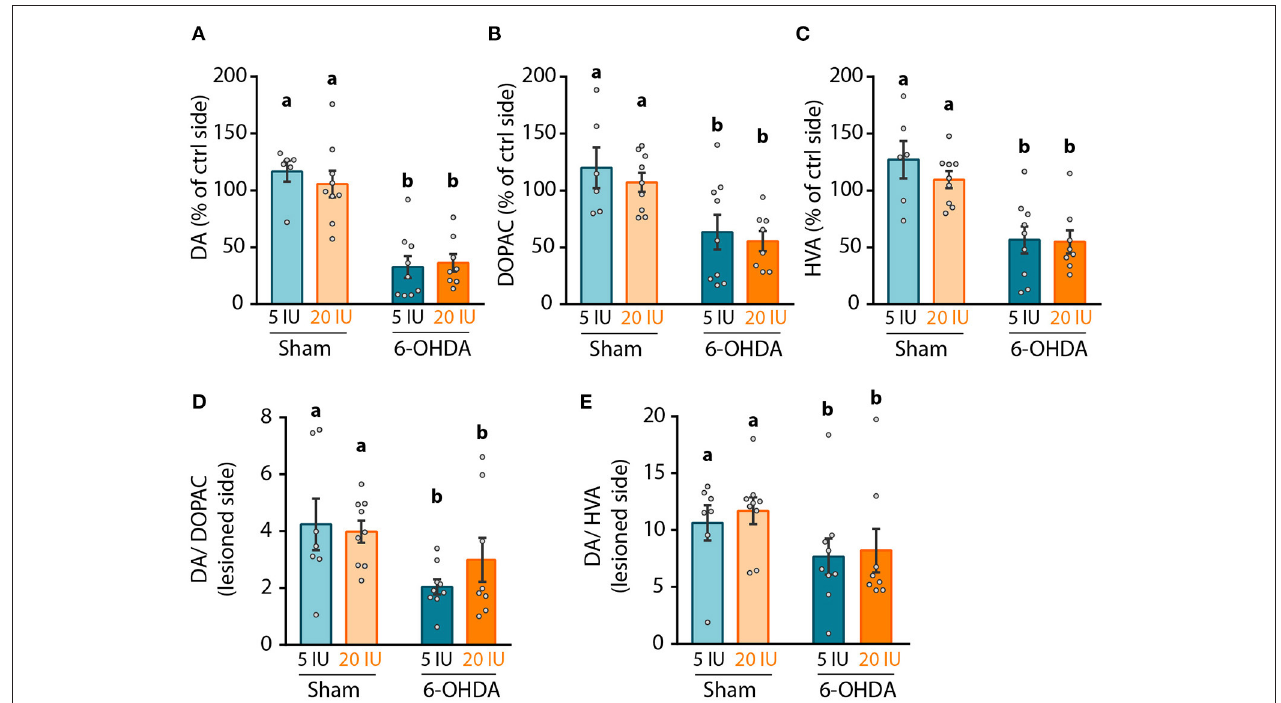
FIGURE 4 | Impact of 6-OHDA lesion and dietary vitamin A on monoamines levels in the striatum. (A–C) Quantification of dopamine (DA) using HPLC coupled to electrochemical detection (A) , 3,4-Dihydroxyphenylacetic acid (DOPAC) (B) , and homovanillic acid (HVA) (C) in the striatum. Results are expressed in pmoles/ug of total proteins. (D,E) Expression of DA/DOPAC (D) and DA/HVA (E) ratios. Results are expressed as means ± SEM with individual data points. a, b: values significantly different ( p < 0.005). Details of the statistical analysis are summarized in Table 3